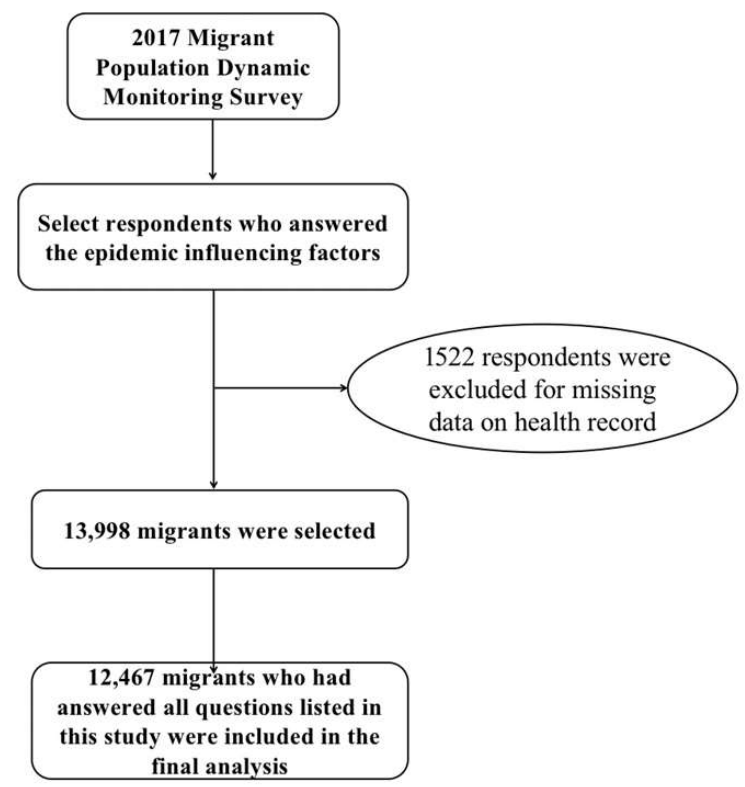
Figure 2. The flow chart of respondents.